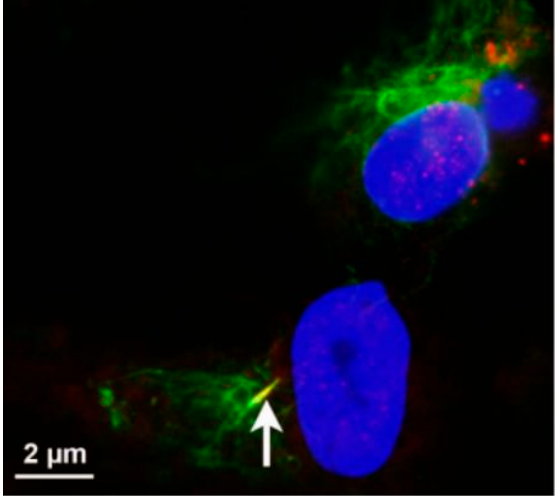
Figure 6. Immunofluorescence (IF) illustration of EC “cilium-like structures”. The white arrow exhibits a gamma-tubulin AC3-positive tubular structure, which is postulated to be a cilium [52]. The “cilium” in Figure 6 was identified using immunocytochemistry, by studying the molecular dynamics of the cytoskeletal protein tubulin. The authors propose that an EC is able to display a singular acetylated tubulin-positive cilium. It is presumed that cilia are engendered from tubulin, which extends between two adjacent ECs